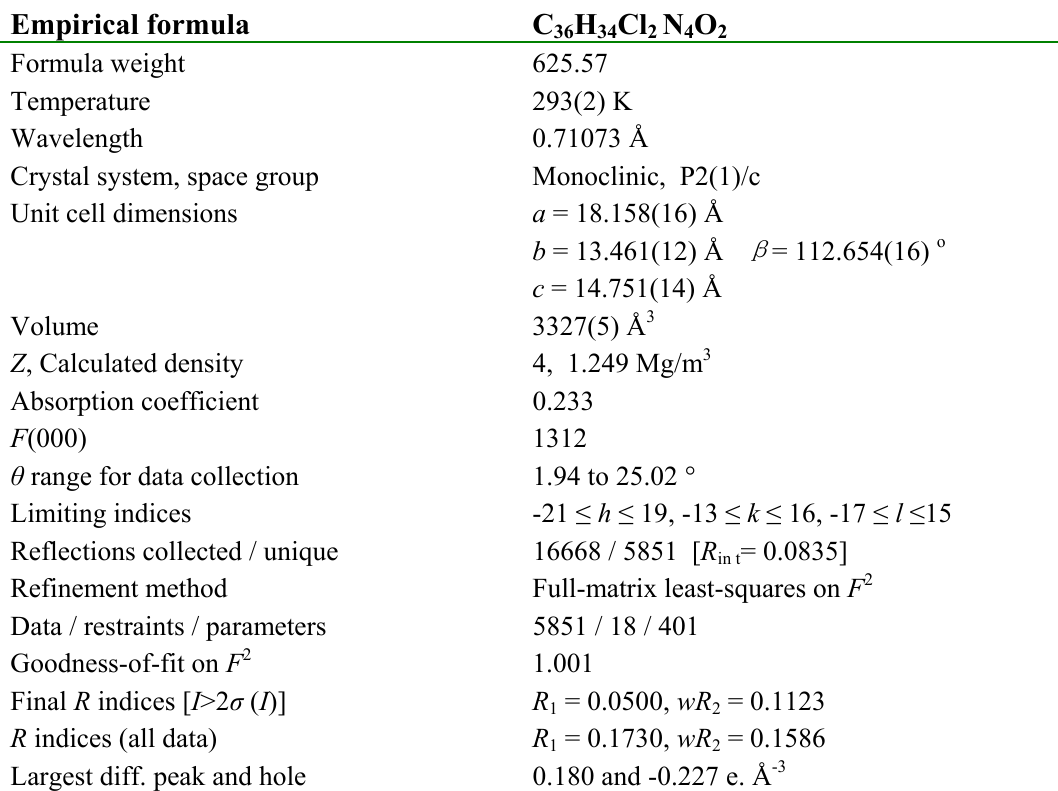
Table 4. Crystal data and structure